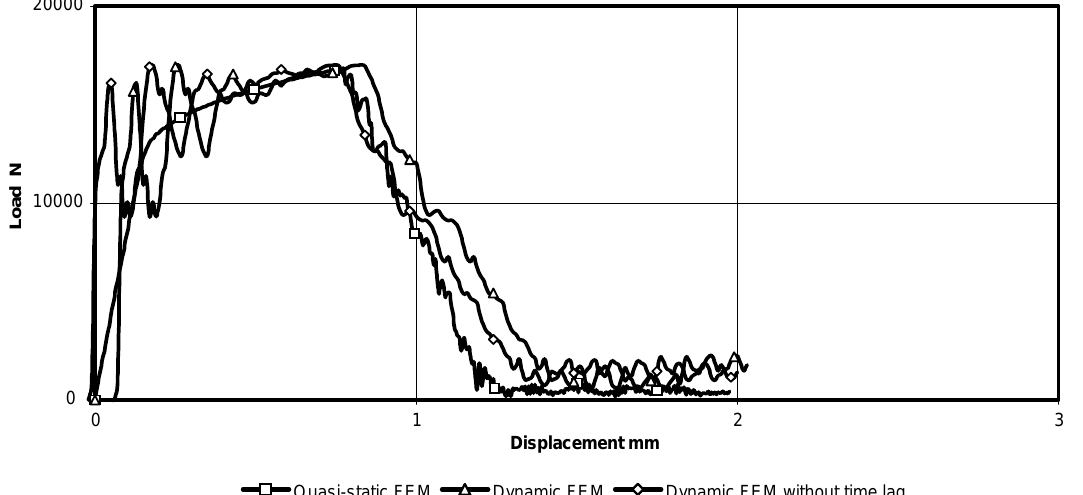
Fig. 14. Quasi-static and dynamic punched tension specimen FE model – Load vs. displacement diagram.